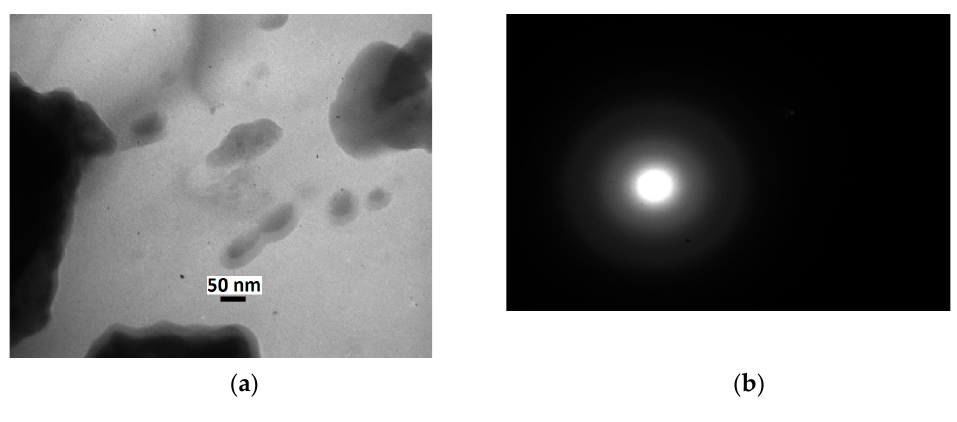
Figure 7. TEM image ( a ) and electron diffraction pattern ( b ) of Pd(OH) 2